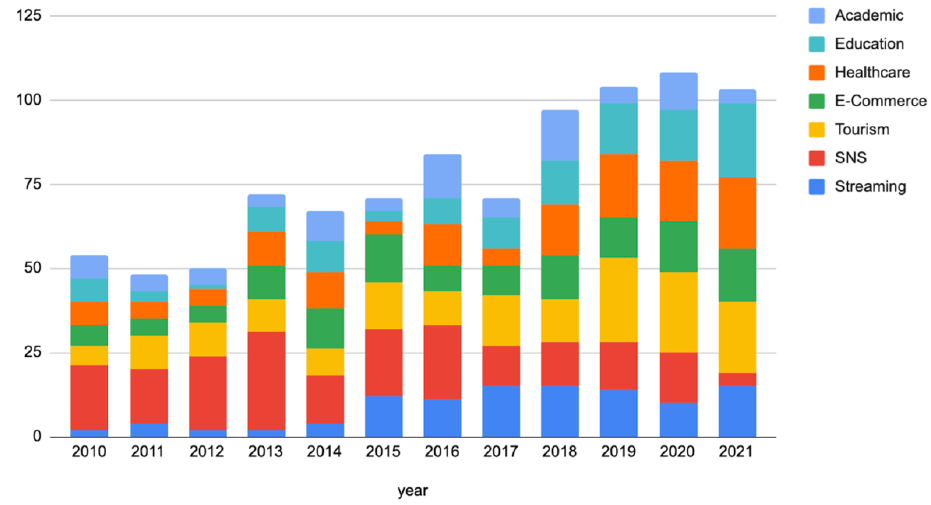
Figure 31. Recommendation system research in seven fields from 2010 to 2021.